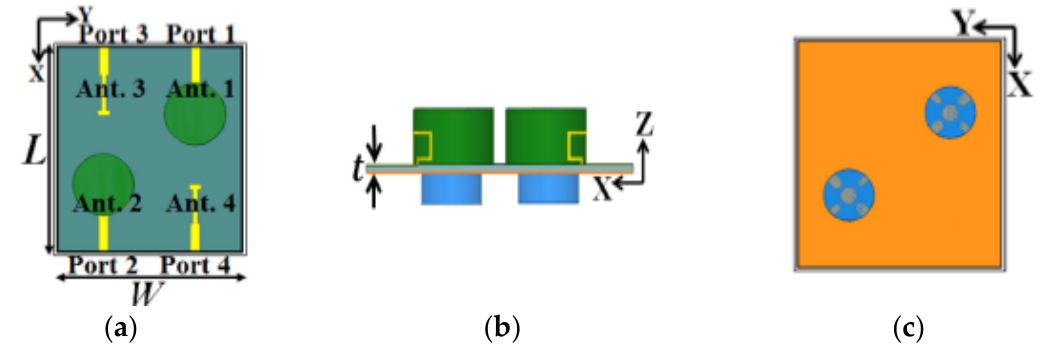
Figure 15. Proposed four-element MIMO DRA: ( a ) front view; ( b ) side view; ( c ) back view [66]. Metal vias can also be used to decrease the mutual coupling between the DRA elements.